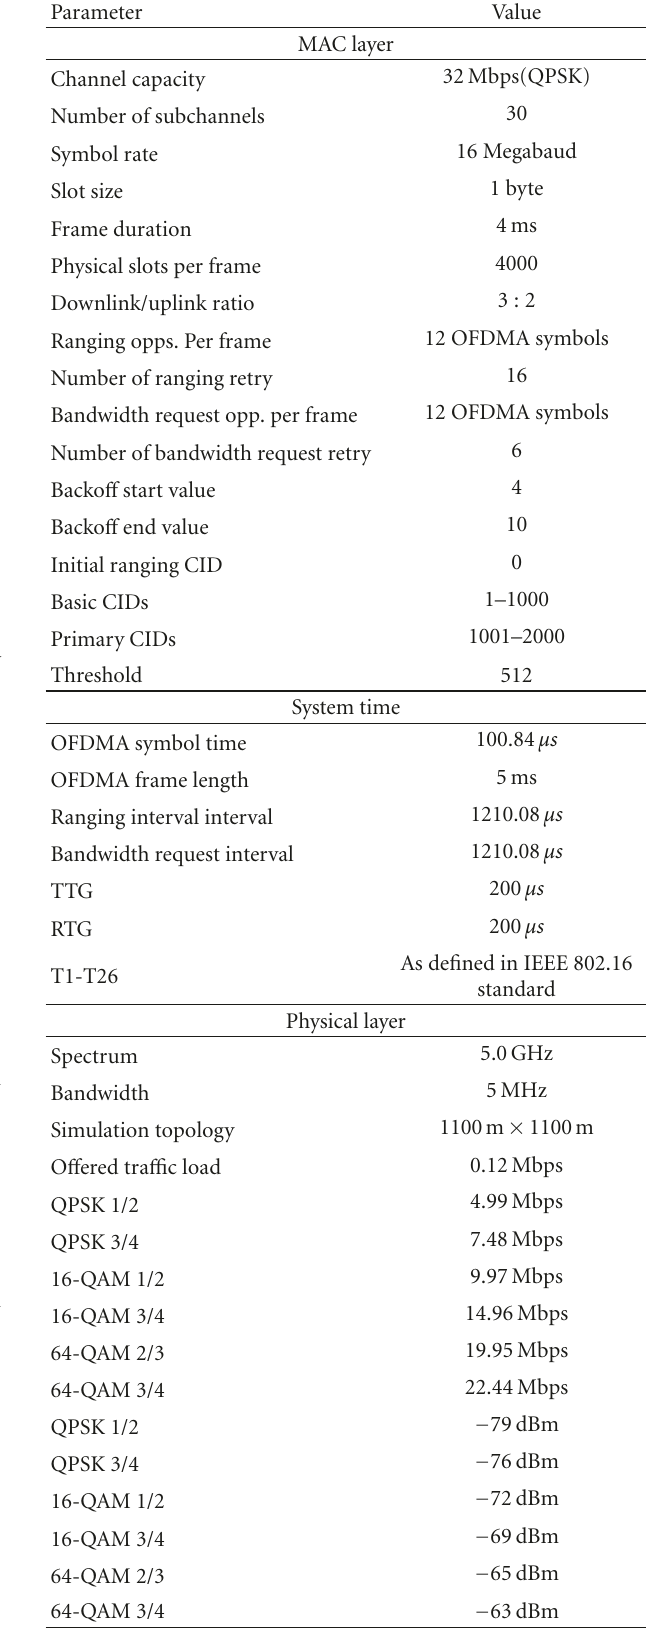
Table 2: Default attribute values used in the